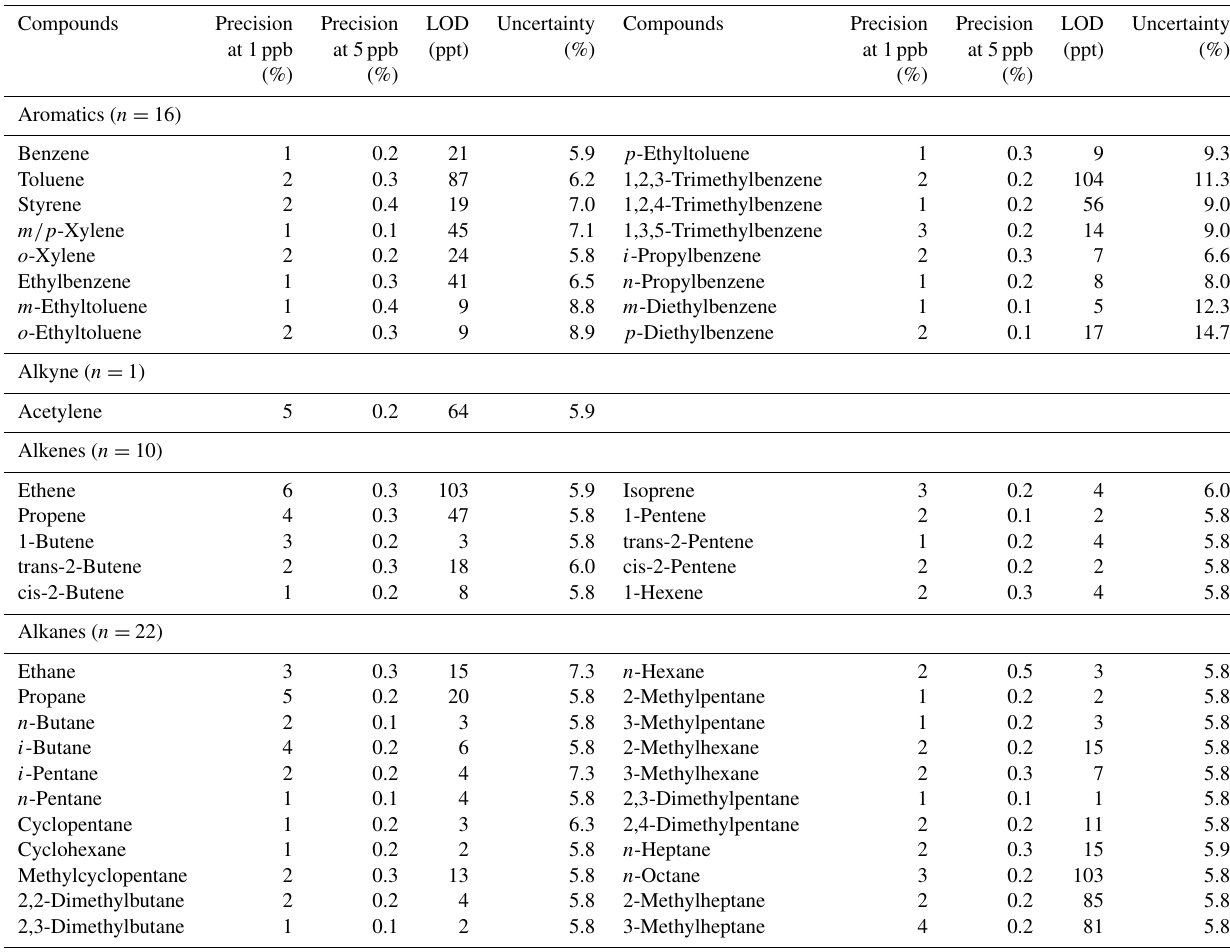
Table 2. Compound-specific precision errors (%), limit of detection (LOD; in parts per trillion – ppt) and total measurement uncertainties (%). Note: ppb – parts per